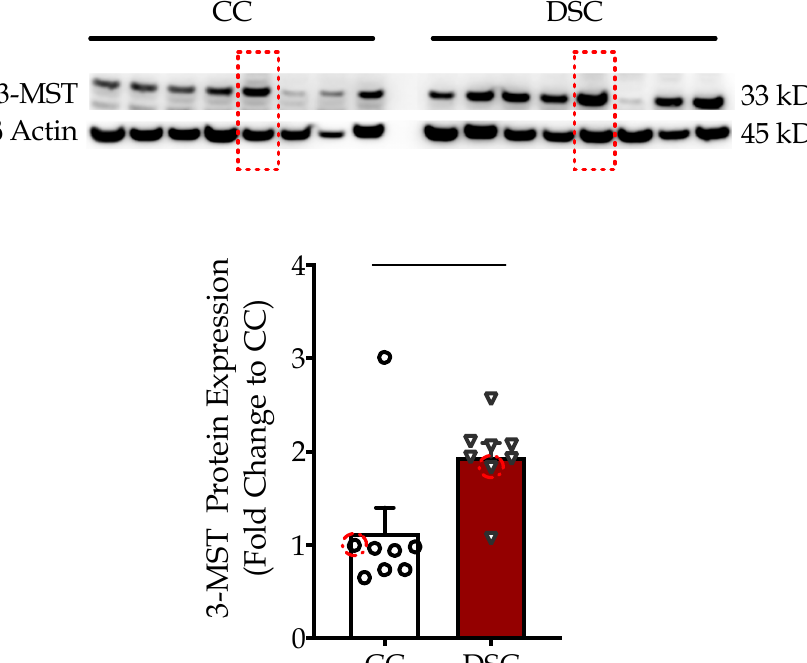
Figure 1. Down syndrome cells (DSC) exhibit significantly higher 3-MST protein expression compared to control cells (CC) as shown by Western blotting. We used β -actin as a loading control. Each bar represents the mean ± SEM of 8 human healthy control fibroblasts and 8 human Down syndrome fibroblasts (summarized in Table 1). ** p < 0.01. Similar to our previous study [9], the normal fibroblast cell line Detroit 551 and the Down syndrome fibroblast Detroit 539 were compared in the subsequent functional studies. 3-MST and β -actin expression in these two selected cell lines are indicated with red dotted squares.